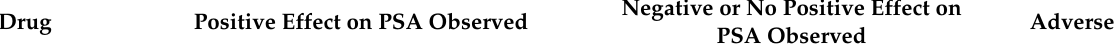
Table 3. Summary of pharmacological intervention in post-stroke aphasia (PSA).